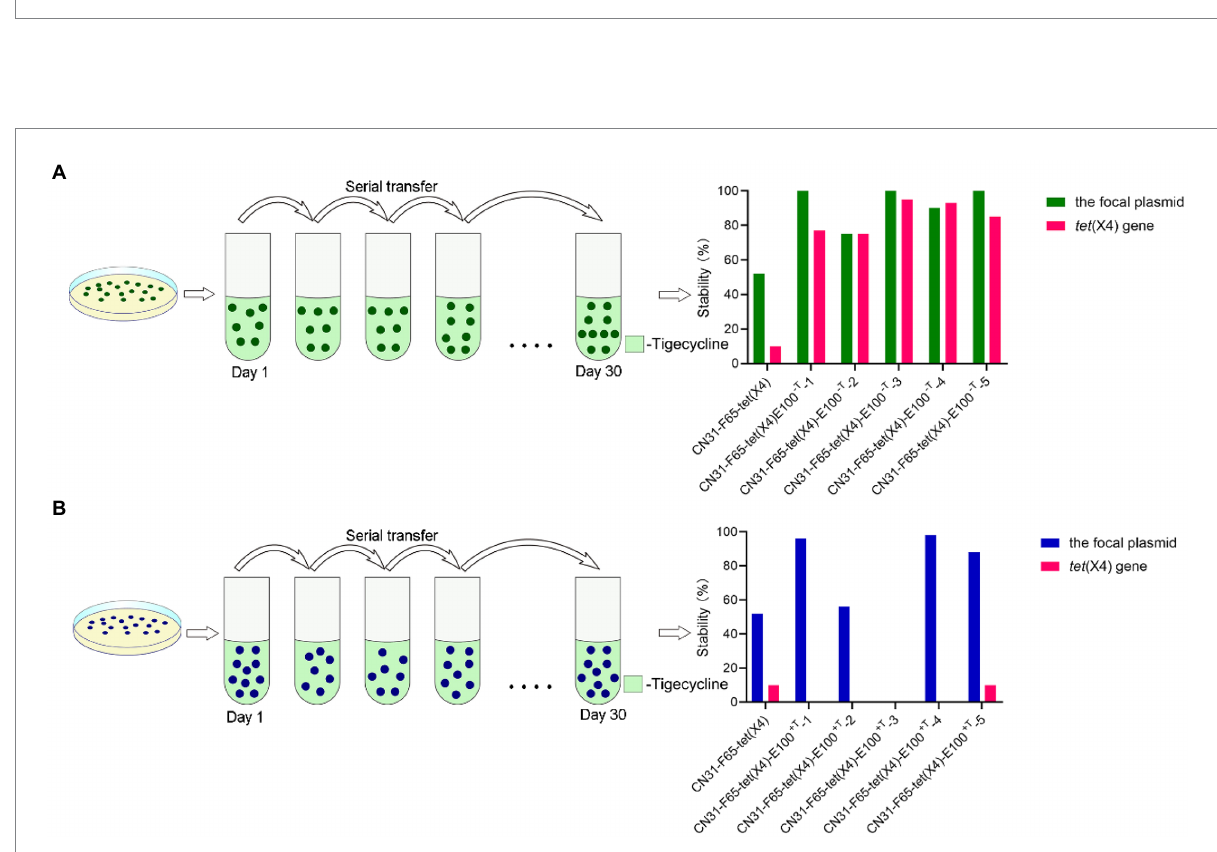
FIGURE 2 Stability of the focal plasmid and tet (X4) gene. (A) Stability of the focal plasmid and tet (X4) gene in five selected strains evolved in antibiotic-free broth and the ancestral strain at the 30 th day. (B) Stability of the focal plasmid and tet (X4) gene in five selected strains evolved in tigecycline containing broth and the ancestral strain at the 30 th